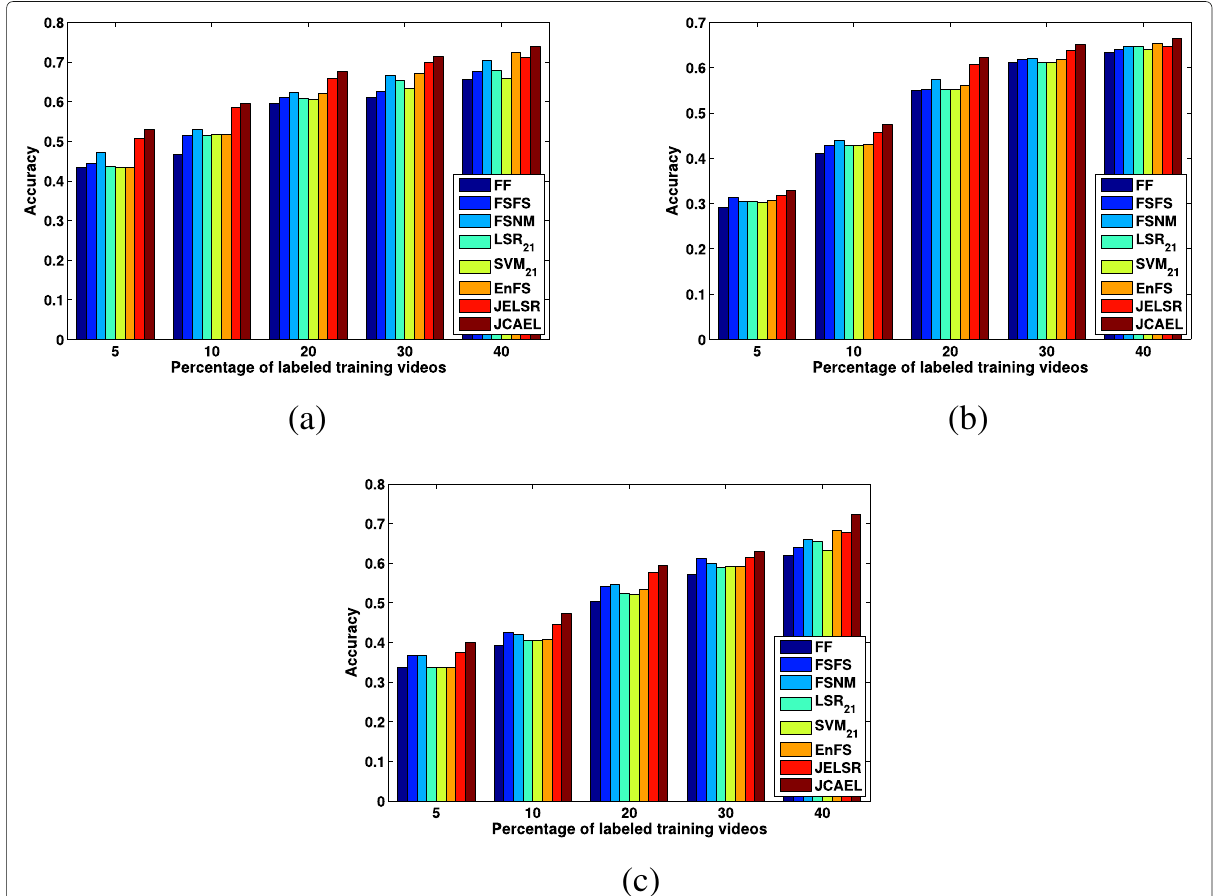
Fig. 2 Classification results of different methods on UCF10 ← AID when the ratios of labeled video data are different. a LMCSVM as classifier. b LSR as classifier. c MCkNN as